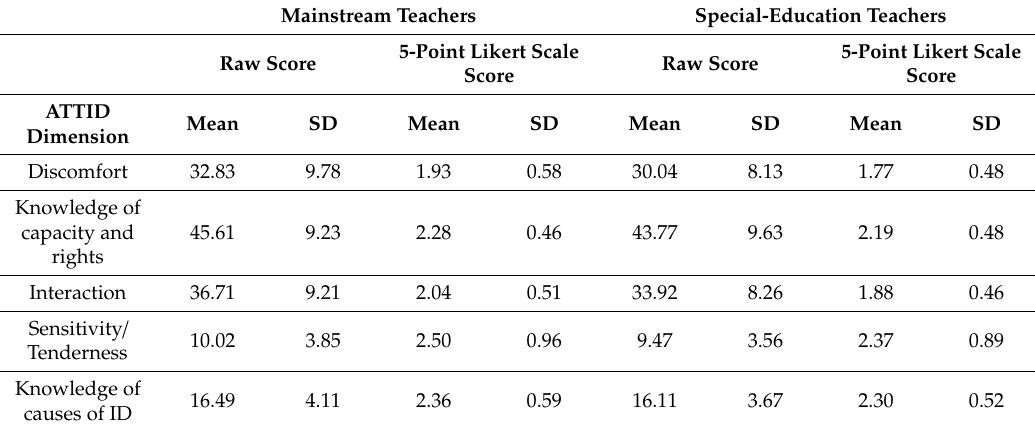
Table 2. Means and standard deviations of raw score and 5-point Likert scale score obtained by mainstream teachers and special-education teachers for each dimension of the Attitudes Toward Intellectual Disability (ATTID) questionnaire. Mainstream Teachers Special-Education